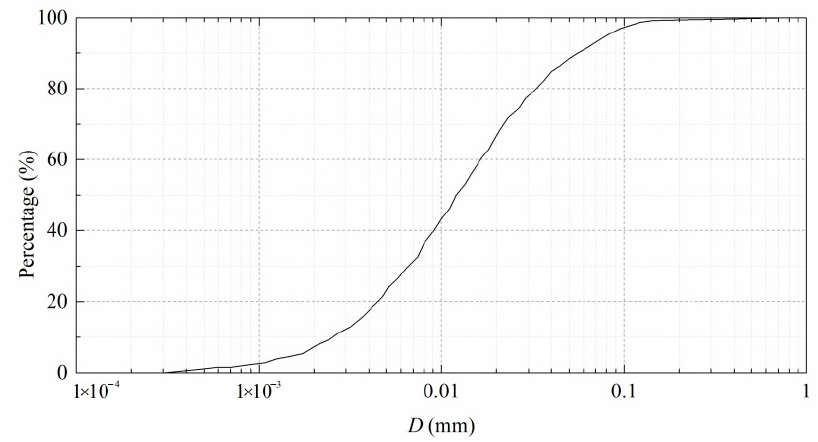
5 of 19 ( b ) ( c ) Figure 4 . Hydrological data at the sluice site. ( a ) Multiyear averaged flow discharge; ( b ) flow fre- quency at a 10 m 3 /s interval; ( c ) cumulative flow frequency. The flow carries fine sediment in the form of both bed load and suspended load. Field measurements are conducted to determine its composition, which shows that the grain